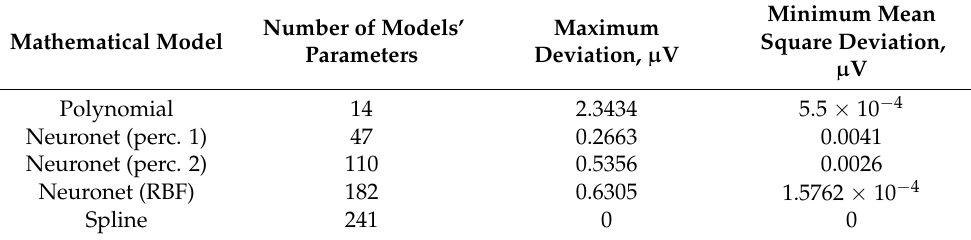
Table 1. The results of mathematical wavelet models obtained for analysis of EEG fragments’